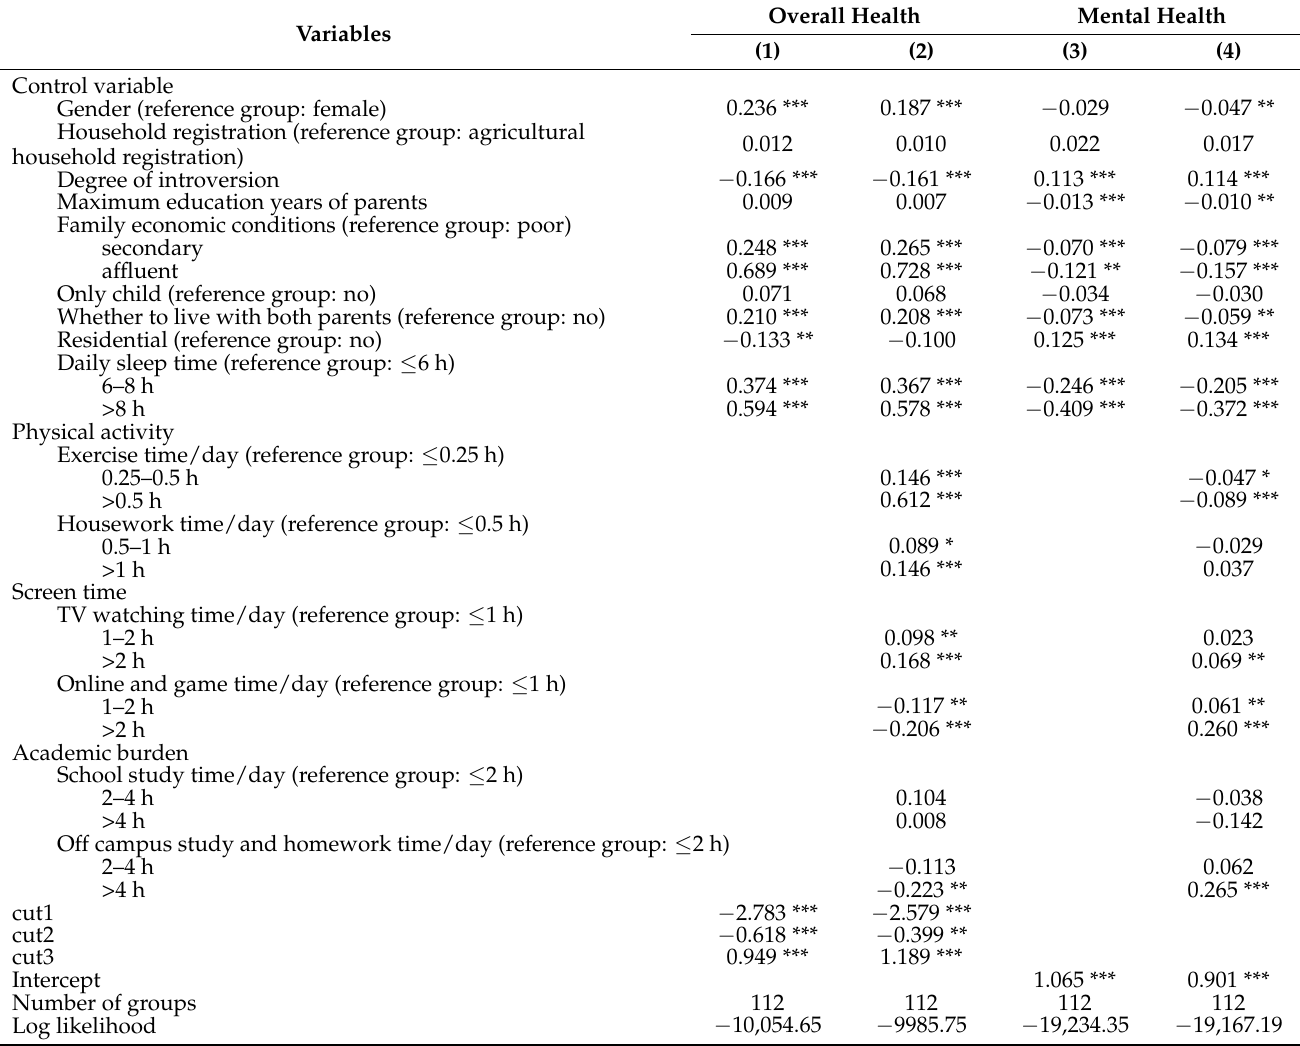
Table 3. Regression analysis of physical activity, screen time, academic burden, and adolescent